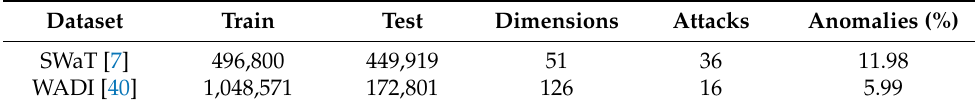
Table 1. Properties of the SWaT and WADI datasets.